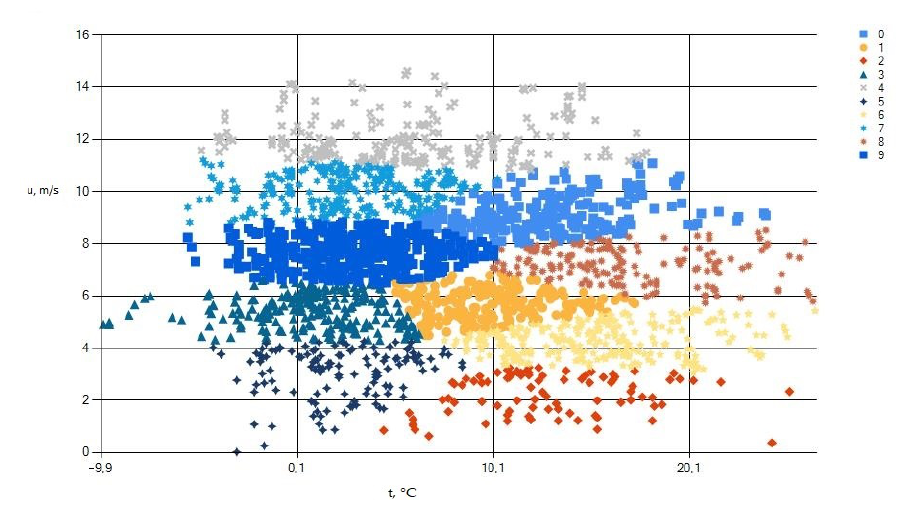
Figure 3. The results of ABL cluster analysis in winter.